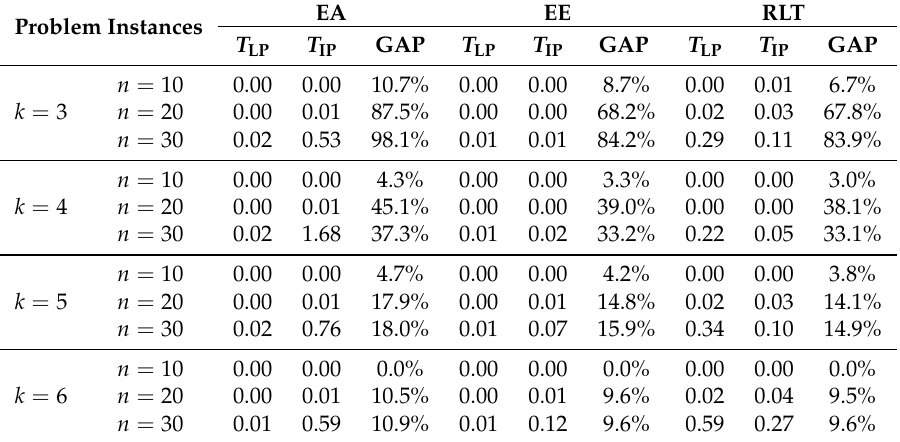
Table 1. Computational results for low-density instances. EA: edge-assignment; EE: extended edge; RLT: reformulation-linearization technique; GAP: optimality